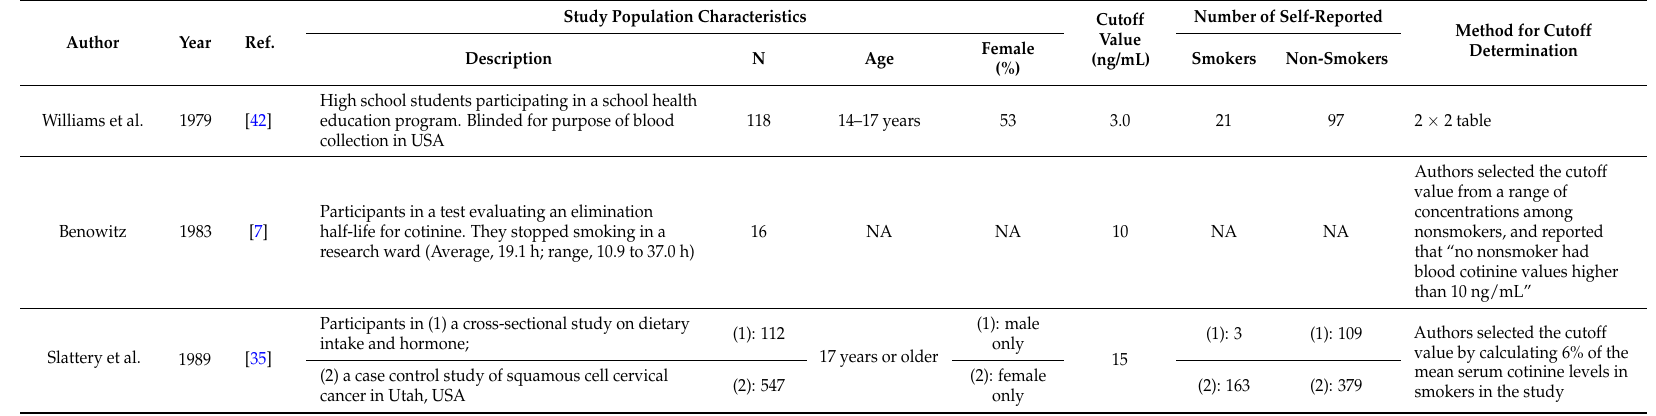
Table 2. Blood cotinine cutoff values and methods of